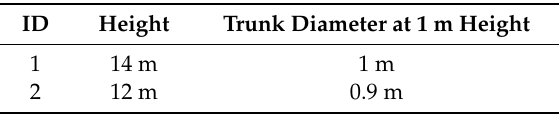
Table 1. Tree Table 1. Tree parameters.